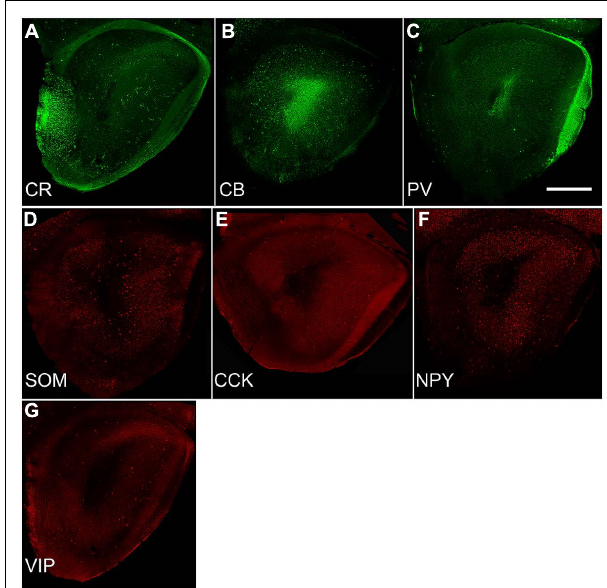
FIGURE 3 | Sections from P30 pups from a standardized location in the caudal OP (see Figure 1C) immunostained for the three calcium-binding proteins (A: calretinin; CR, B: calbindin; CB, C: parvalbumin; PV) and four peptides (D: somatostatin; SOM, E: cholescytokinin; CCK, F: neuropeptideY; NPY, G: vasoactive intestinal polypeptide;VIP). Note the wide differences in density and number. Comparisons with Figure 2G demonstrate that these seven varieties account for only a small proportion of the total population of GABAergic neurons (Kay and Brunjes, 2014). Scale bars = 300 μ